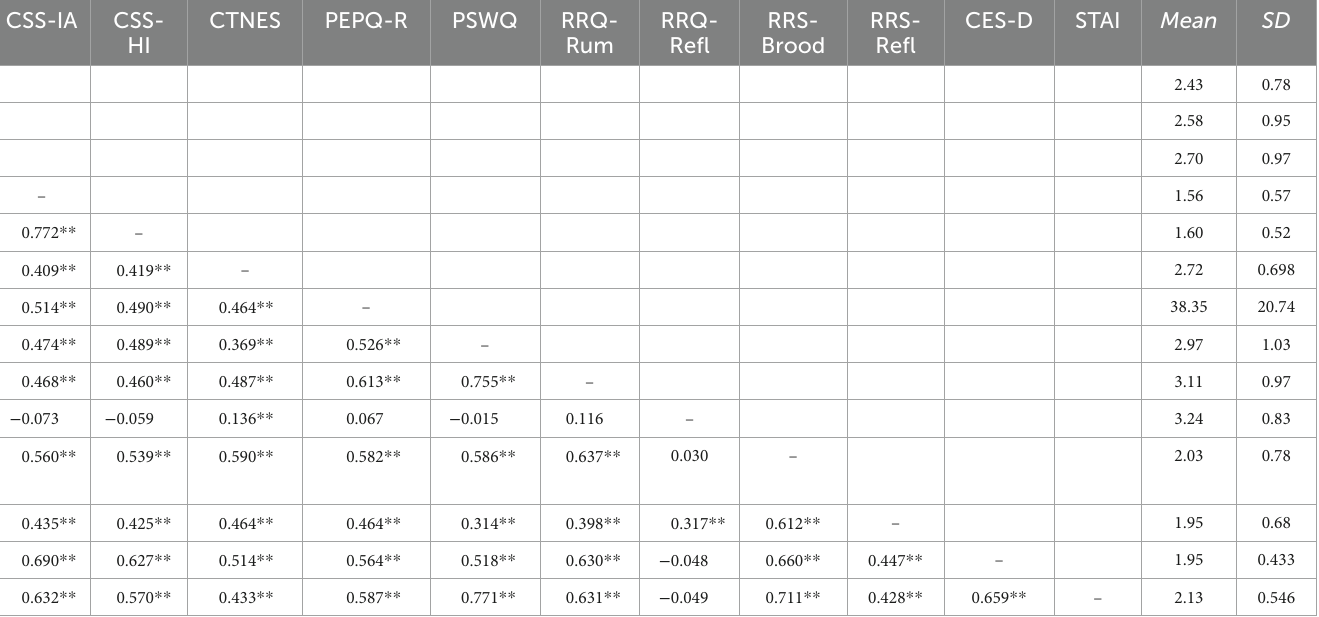
TABLE 1 Bivariate correlations (Spearman’s rho) of inattention variables and symptom